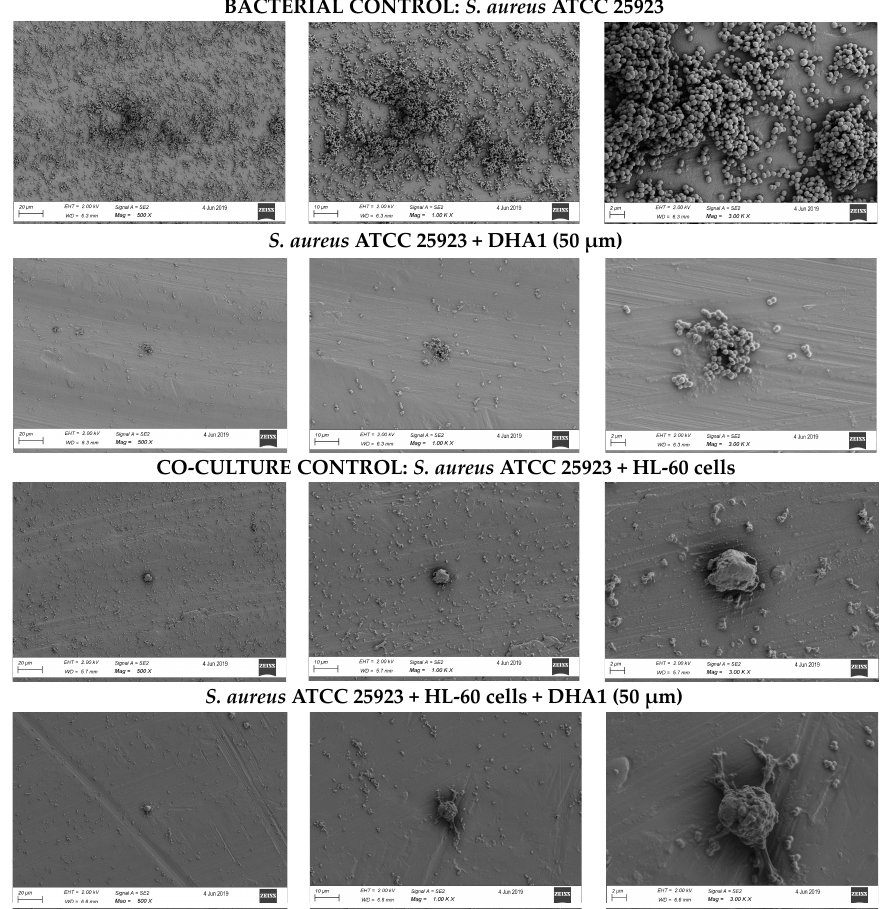
Figure 5. Representative images acquired by SEM. From left to right the same section of the titanium coupon is shown with di ff erent magnification, 500, 1000 and 3000 × . Upper row of images, bacterial control, i.e., coupons incubated with S. aureus ATCC 25923 only. Second row, titanium coupons incubated with S. aureus ATCC 25923 and treated with DHA1 . Third row, cocultured control, titanium coupons incubated with S. aureus ATCC 25923 and HL-60 cells simultaneously. Fourth row, titanium coupons cocultured with S. aureus ATCC 25923 and HL-60 and treated with DHA1